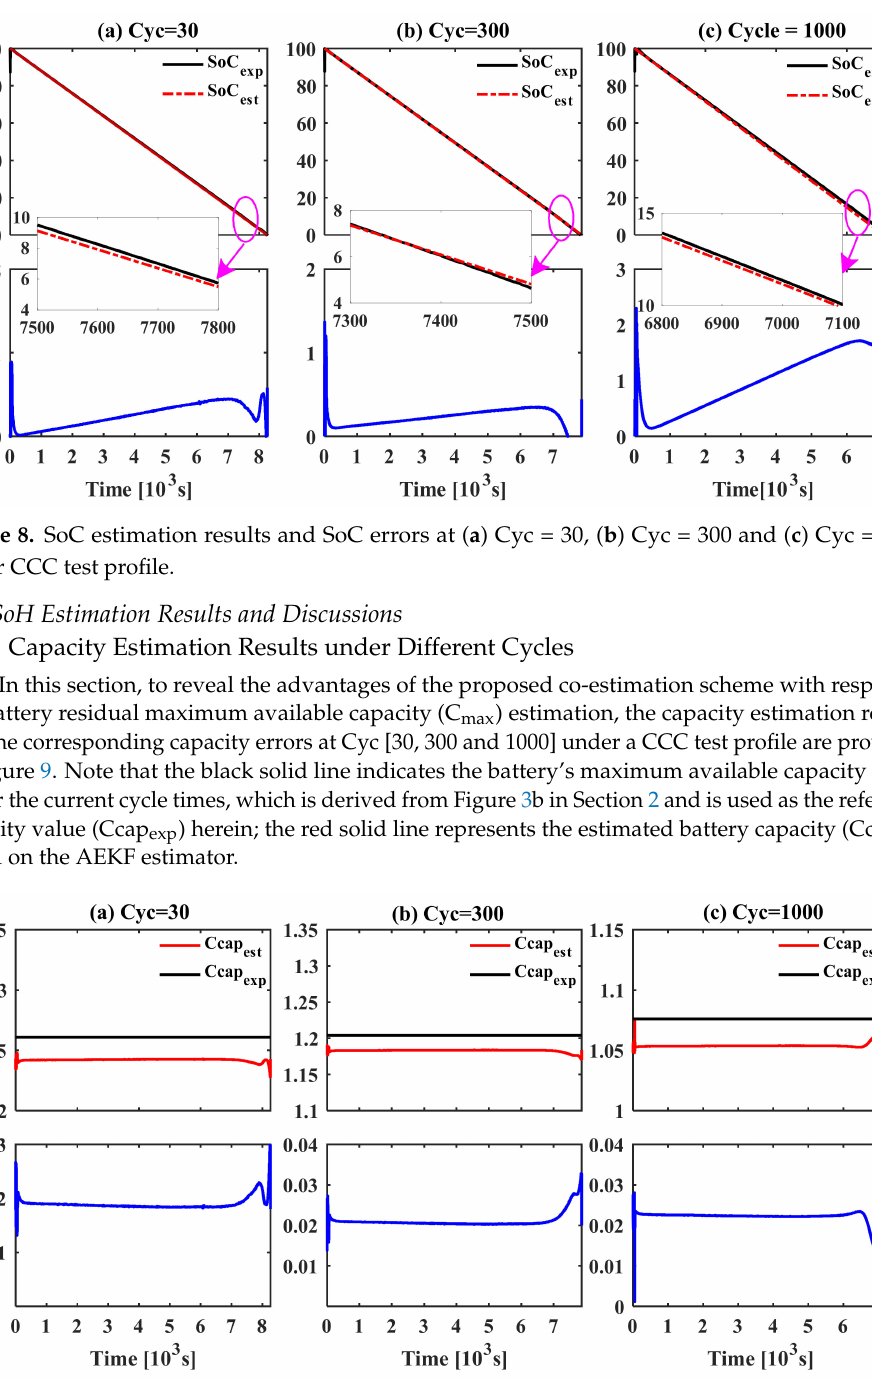
Figure 9. Capacity estimation results and errors at ( a ) Cyc = 30, ( b ) Cyc = 300, ( c ) Cyc = 1000 under CCC test